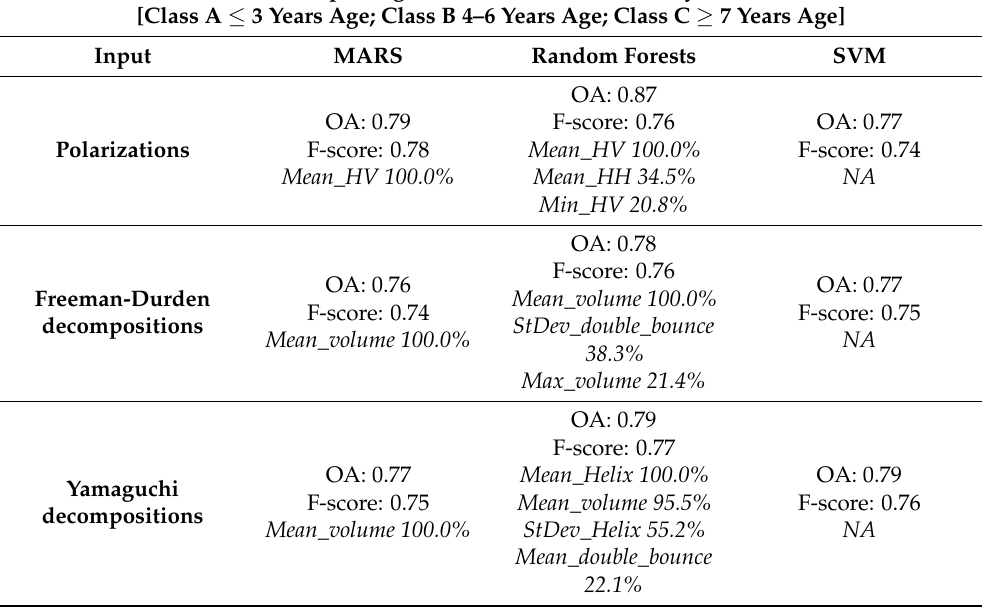
Table 2. Overall accuracy (OA) and F-score for the classification of 3 poplar age classes, obtained with MARS, Random Forests and SVM models using 10-fold cross validation. The Variable Importance are also reported in italic for MARS and Random Forests. 3 Poplar Age Classes—Overall Accuracy